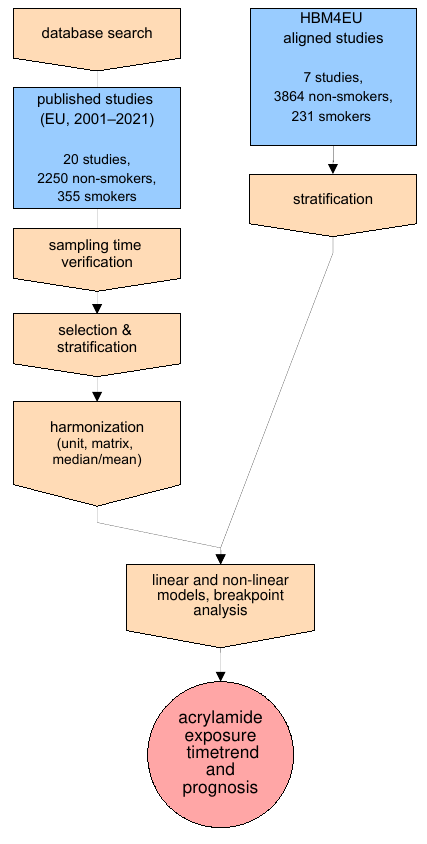
Figure 1. Flowchart of study